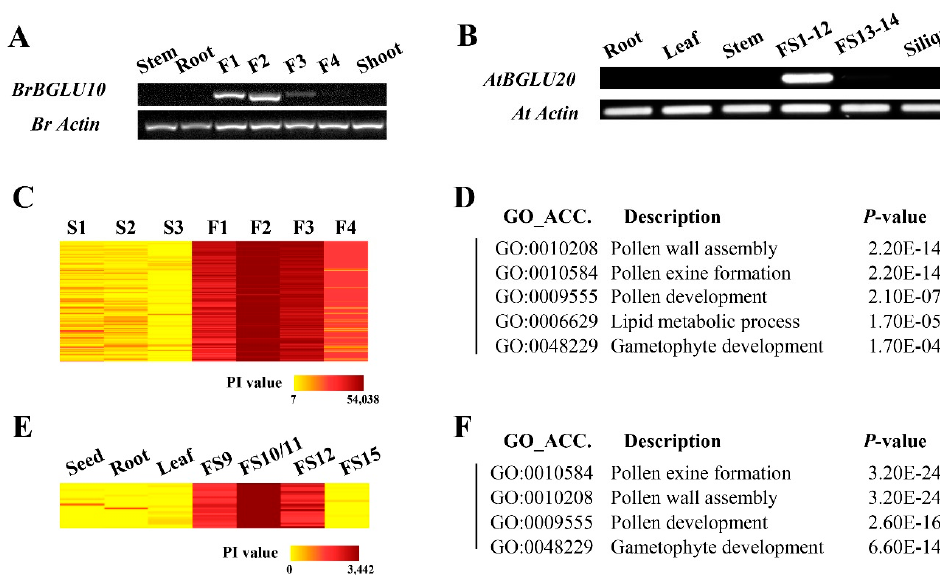
Figure 4. Analysis of expression of BrBGLU10 and AtBGLU20, and Gene Ontology (GO) enrichment of co-expressed genes. A , Expression of BrBGLU10 in different tissues and floral bud stages in B. rapa . B , Expression of AtBGLU20 in different tissues and floral bud stages in Arabidopsis . C , Expression patterns of BrBGLU10 and its co-expressed genes in sterile and fertile B. rapa floral buds, based on previously published microarray data [29]. D , GO enrichment analysis of genes co-expressed with BrBGLU10 . E , Expression pattern of AtBGLU20 and its co-expressed genes in various tissues of Arabidopsis , which was performed using the Arabidopsis eFP Browser